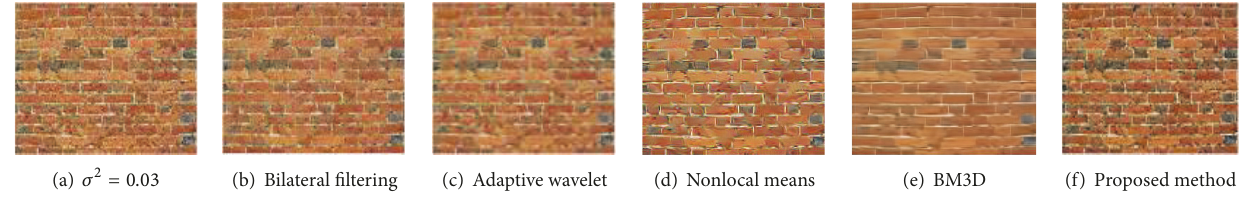
Figure 10: Image 9: comparison of various experimental results under noise variance 𝜎 2 = 0.03